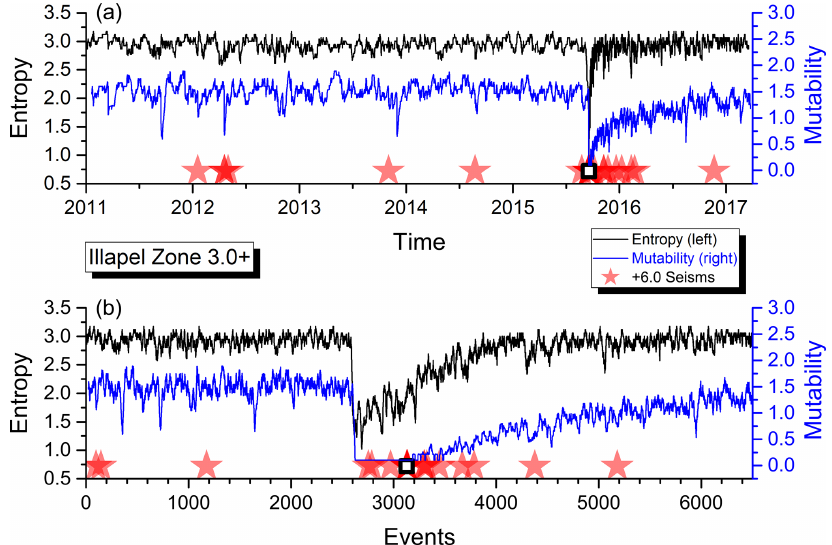
Figure 4. Shannon entropy and mutability as functions of real time (a) and natural time (or sequence of events, b ) for the seismic activity of zone B. The open star marks the position of the earthquake identified in Table